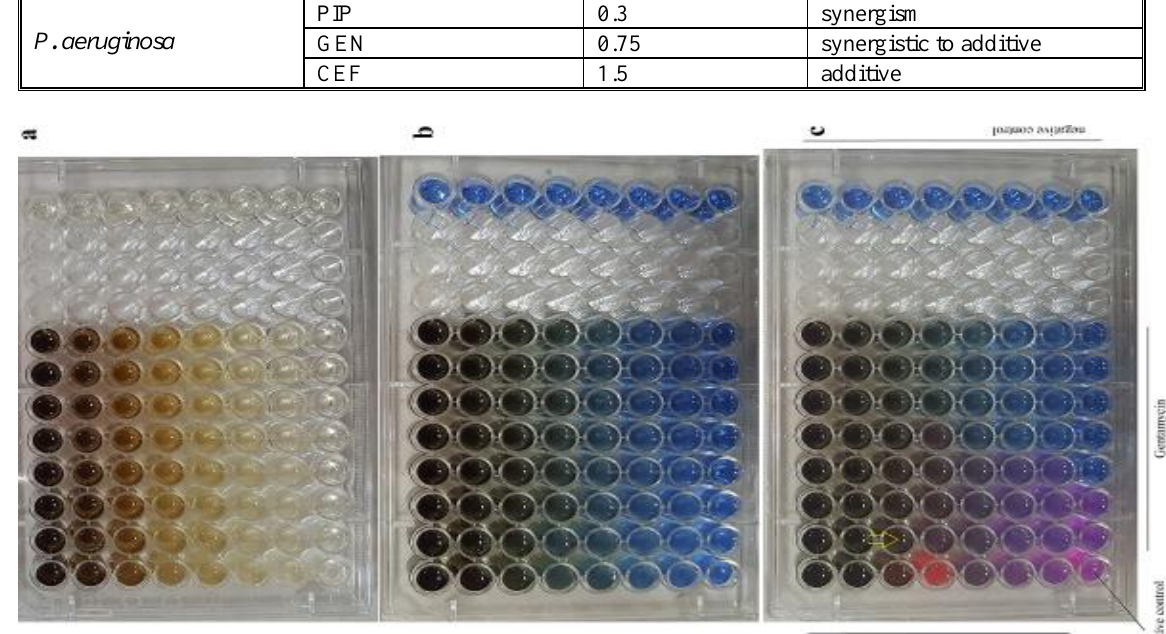
Figure 3. Checkerboard test for determination of combined antibacterial activity of Gentamicin and Scrophularia. striata extract against P. aeruginosa (ATCC 27853), a) after incubation, b) after adding the resazurin solution and c) after incubation of